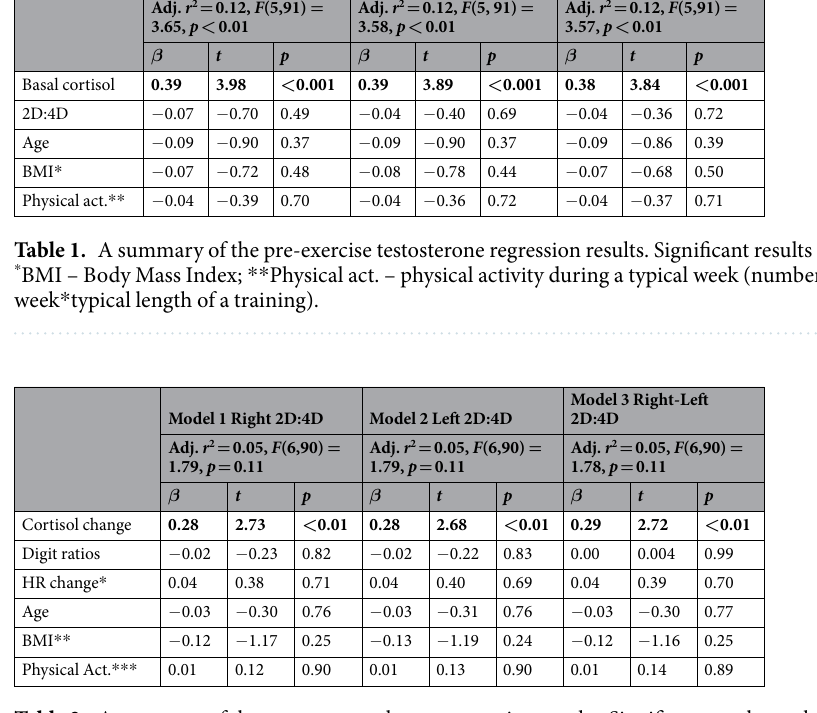
Table 2. A summary of the testosterone change regression results. Significant results are bolded (N = 97). *